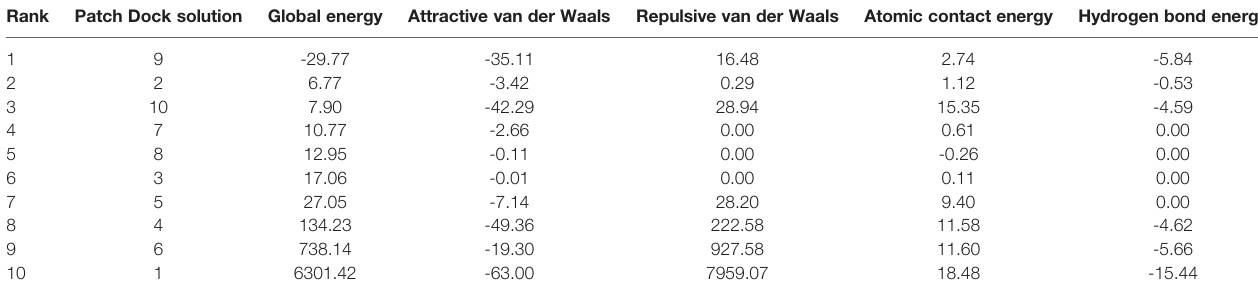
TABLE 5 | Top ten best re fi ned docked solutions generated using FireDock. Energy is presented in kJ/mol. Rank Patch Dock solution